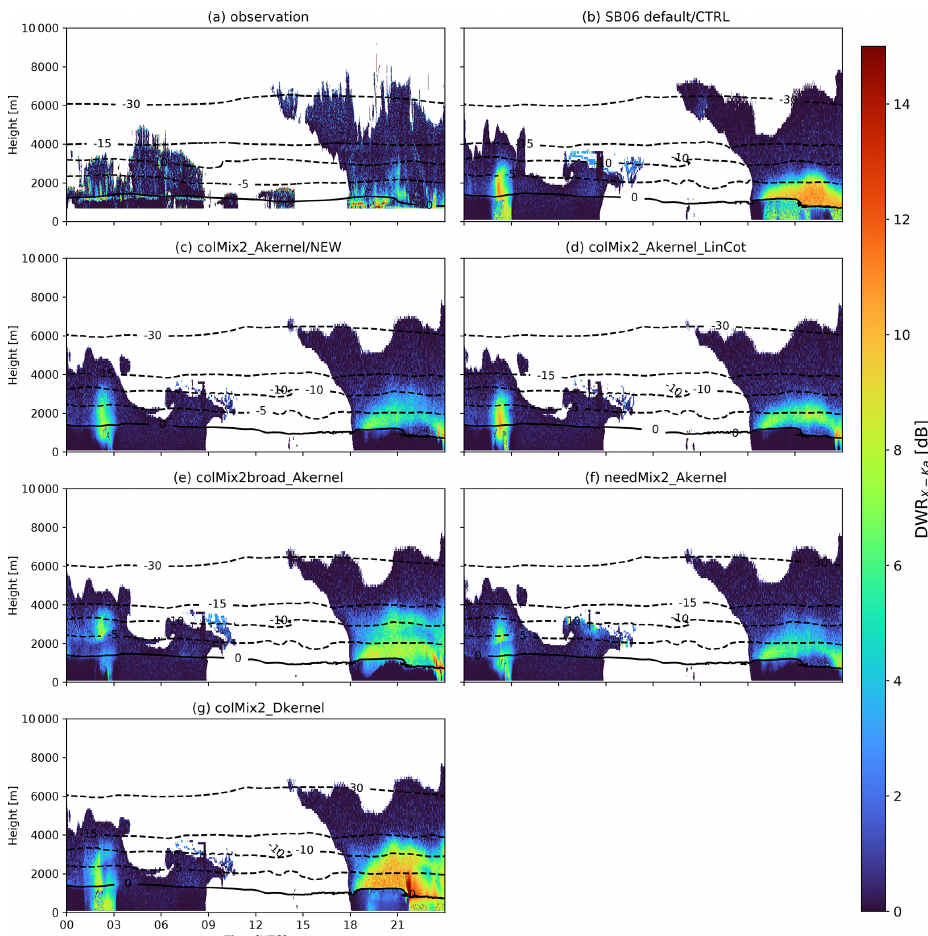
Figure 9. Same as Fig. 8 but displaying DWR X,Ka , which is sensitive to mean mass diameters of 1 to